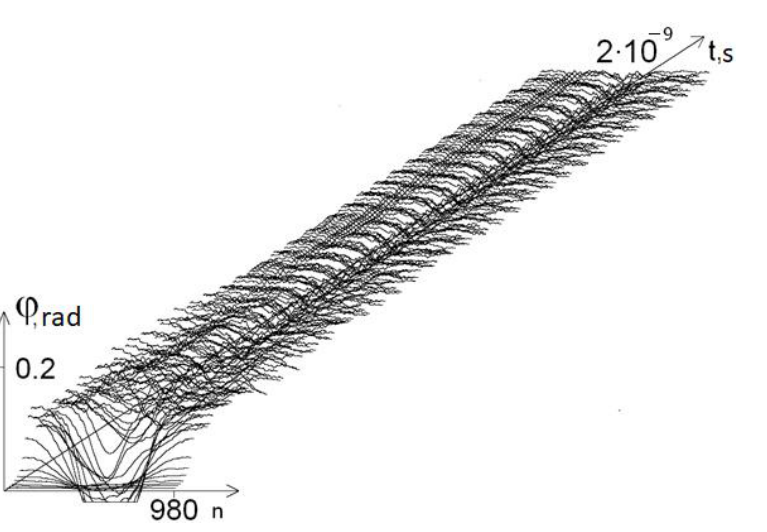
Figure 4. The average angular deviations (with a vertical shift) of the first DNA chain with 40A substitution for different orders of p frequency of external periodic exposures: 1— ω = 10 11 s –1 , 2— ω = 5 × 10 10 s –1 , 3— ω = 10 10 s –1 , 4— ω = 5·10 9 s –1 , 5— ω = 10 9 s –1 , 6— ω = 10 8 s –1 , and 7— ω = 0. Figure 5 shows the graphs fragments of the average angular deviations of the first chain at ω = 10 8 s –1 for molecules in which 40 bases in the middle of the initial molecule were replaced by bases A, T, G, and C, and Figure 6, which shows molecules where 40 and 100 bases in the middle of the initial molecule were replaced by bases A. It can be seen from these figures that the frequency and amplitude of the oscillations of the DNA mole- cule depended on the nucleotide sequence.